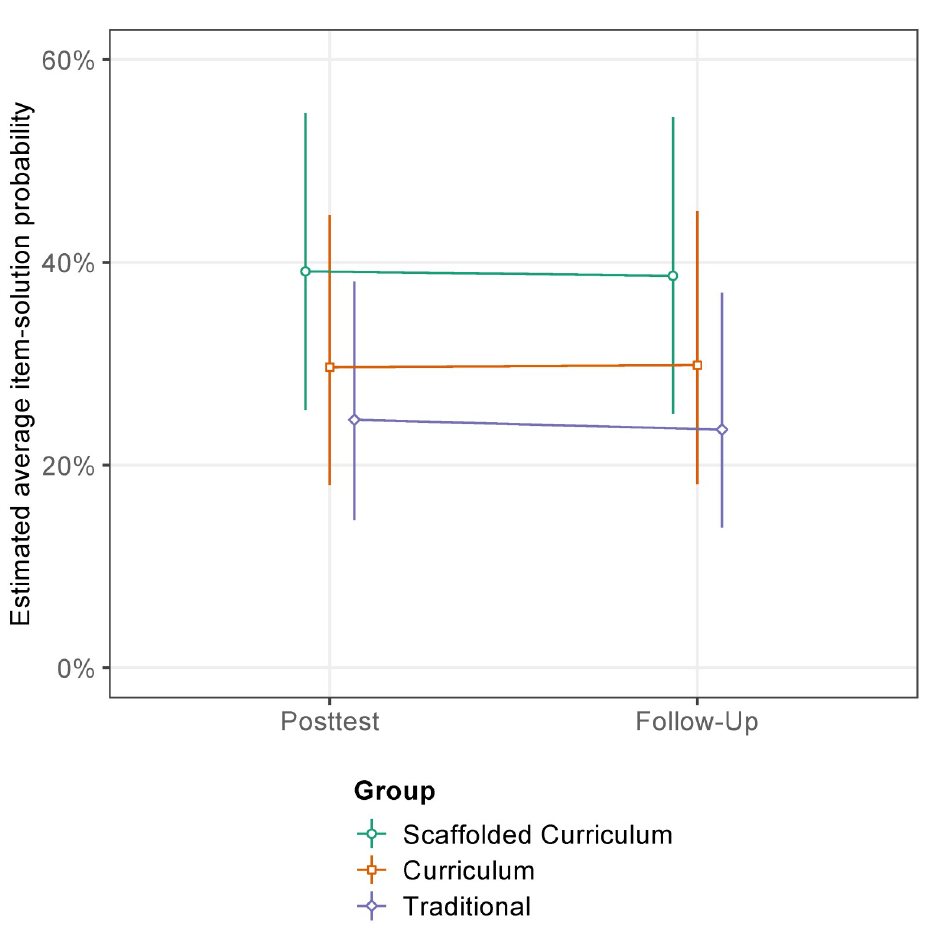
Fig 3. Development of students’ fraction knowledge. Development is shown from the posttest (immediately after the four weeks of instruction during the intervention, i.e., 15 lessons) to the follow-up test (additional eight weeks after the posttest) as estimated average item-solution probabilities, predicted by the generalized linear mixed model. Error bars represent 95% confidence